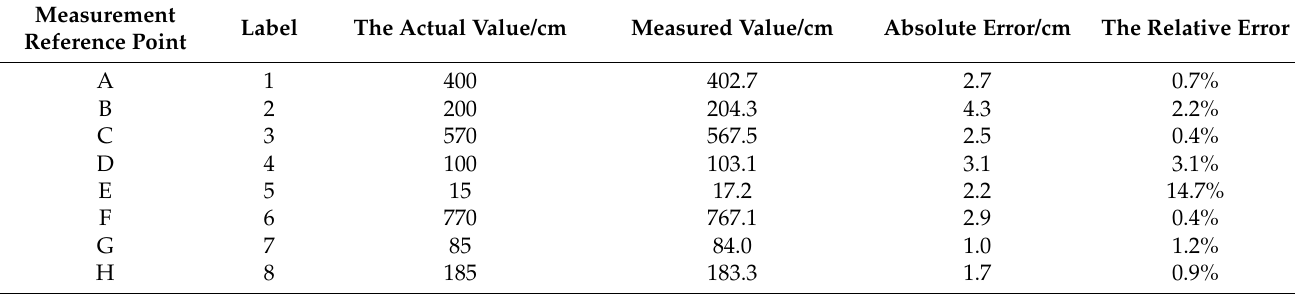
Table 8. Measurement data with a particle count of